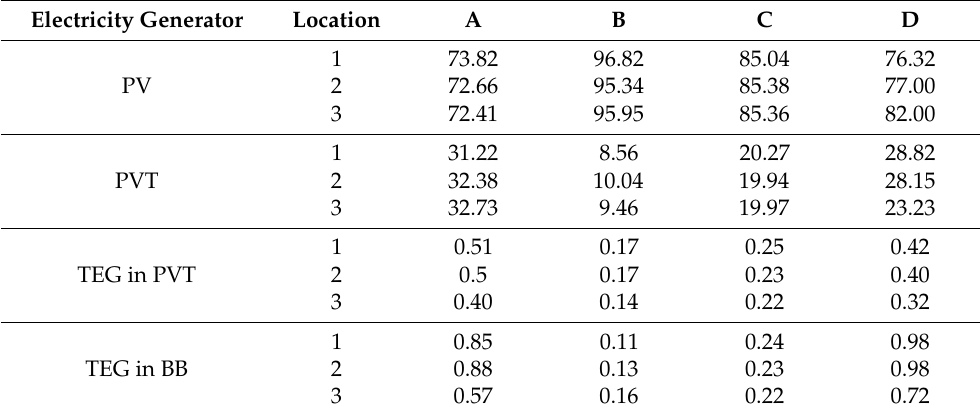
Table 9. Gross electricity fraction obtained by each power technology.